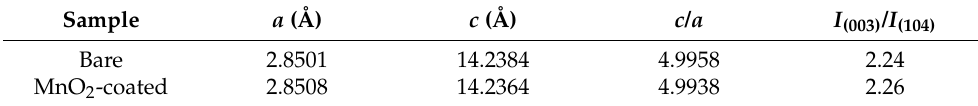
Table 1. Lattice parameters of the LTMO before and after the MnO 2 modification.